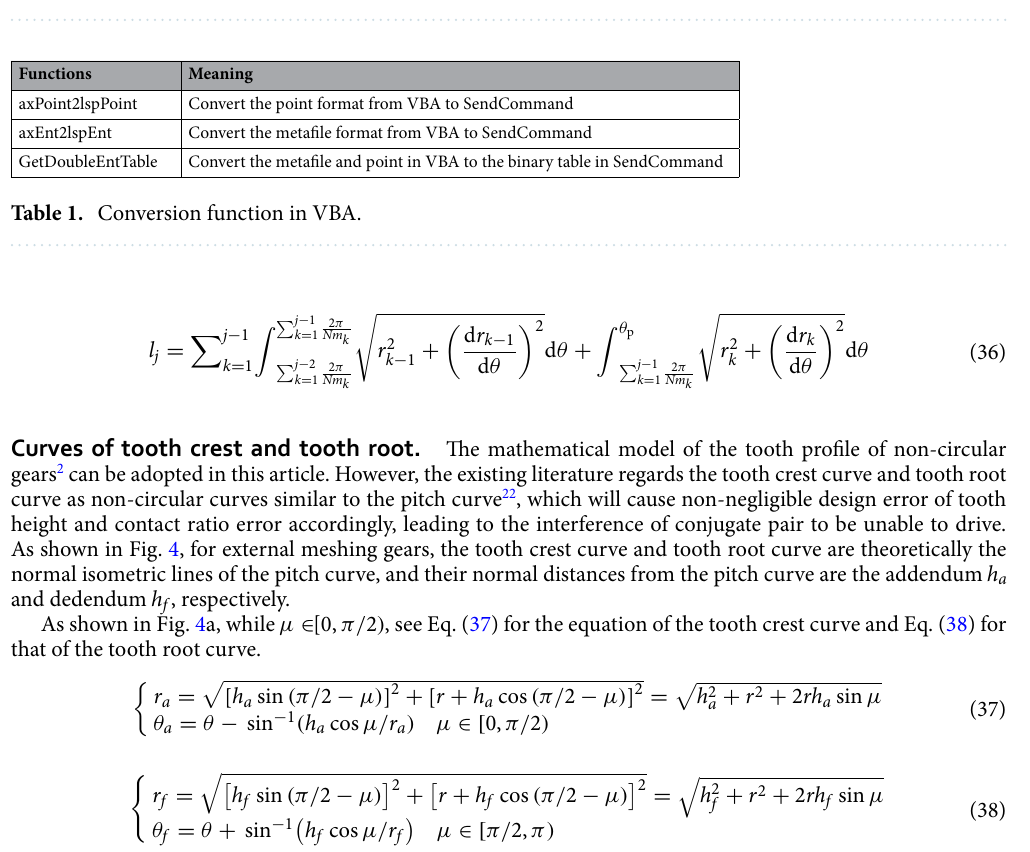
Figure 4. Tooth crest curve and tooth root curve. ( a ) µ